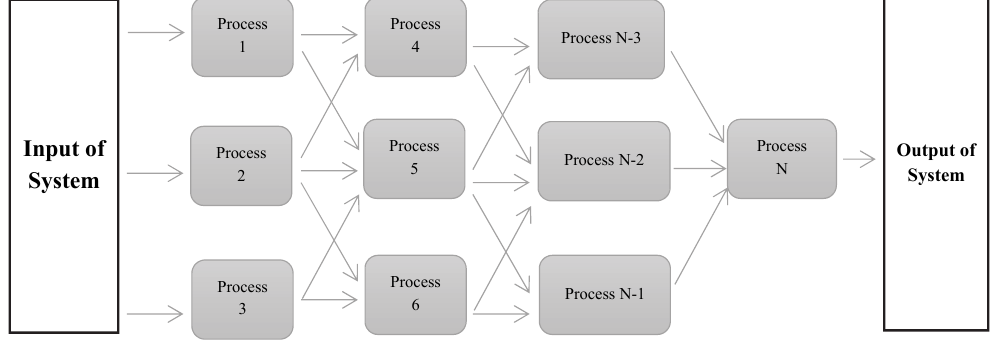
Fig. 9. A general overview of multi-process